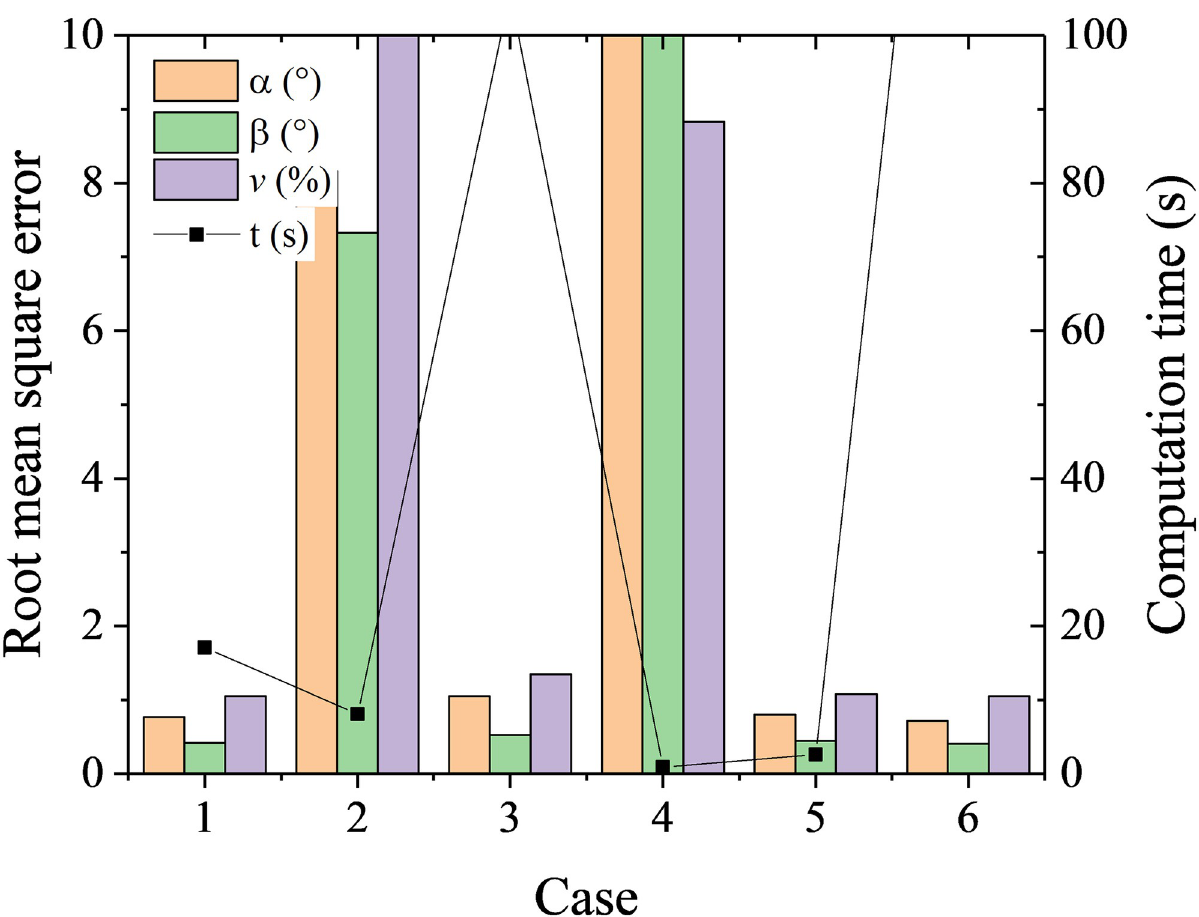
Fig 9. RMSEs and computation time at different cases with support vector machines.